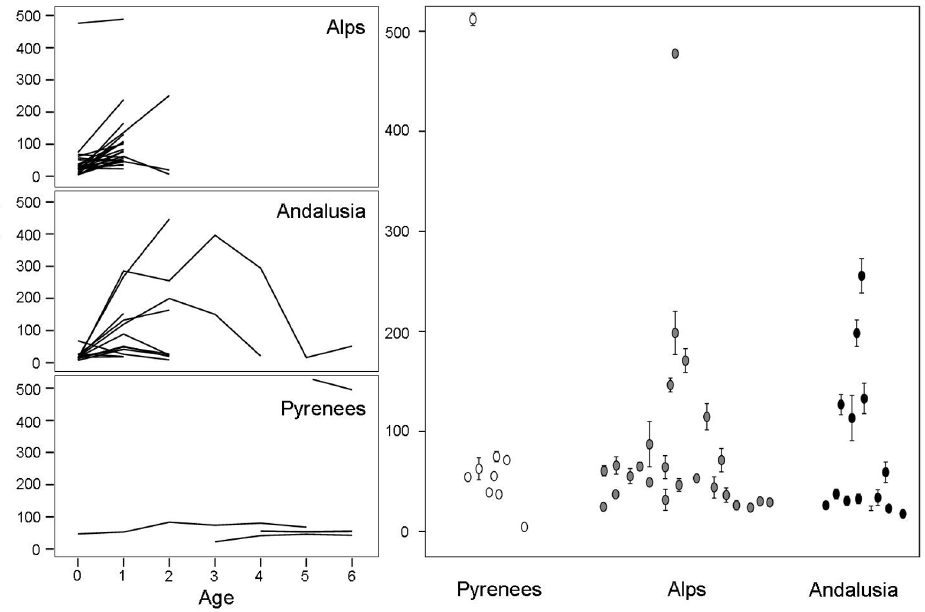
Figure 3. Interpopulation variability in daily average distances travelled by pre-adult bearded vultures. Left: daily average distances travelled according to age classes. Right: average ( 6 s.e.) differences among subpopulations.